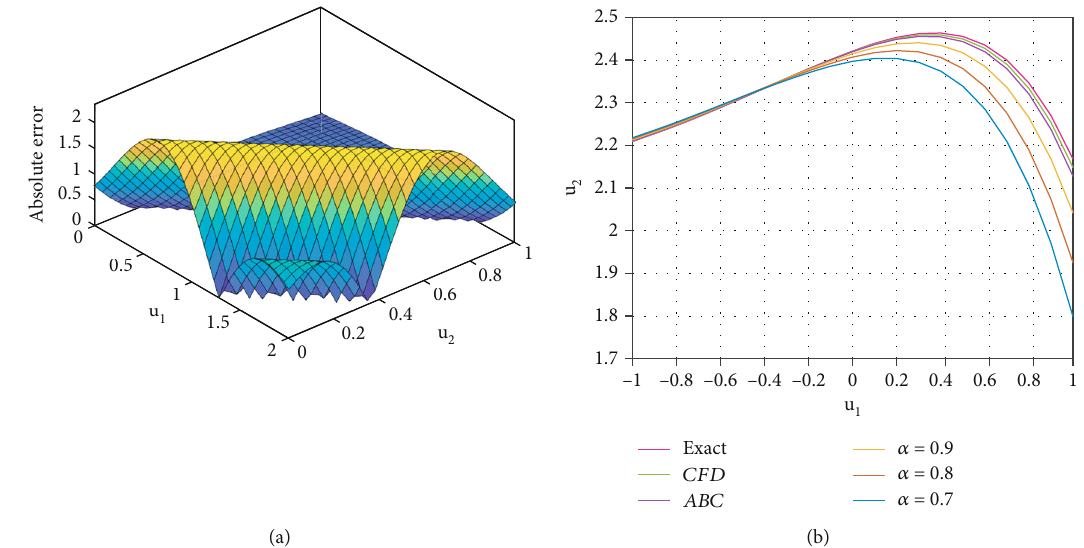
Figure 9: (a) 3D view of absolute error for g ð u when t = 0 : 7 :